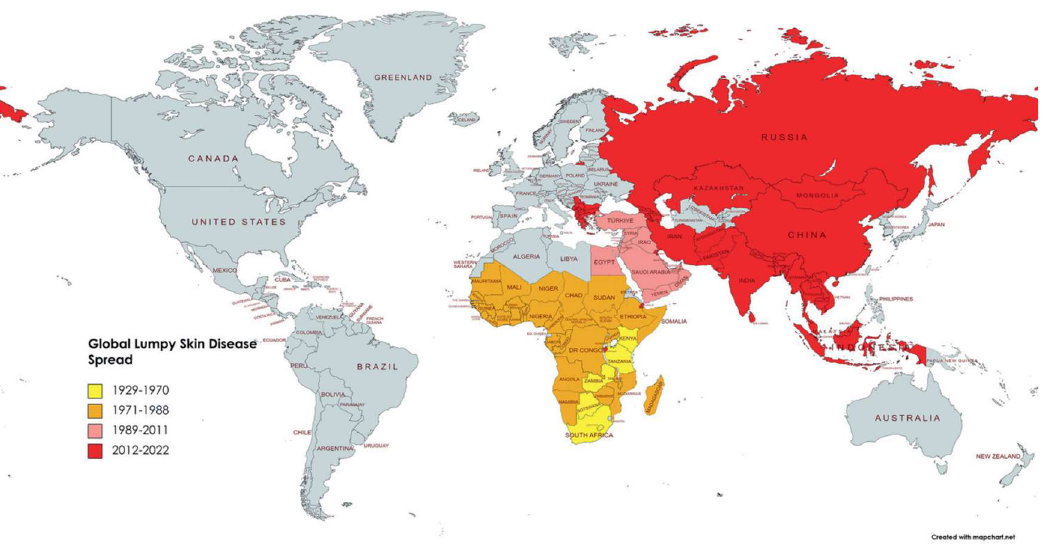
Figure 3. Lumpy skin disease prevalence worldwide and over time from 1929 to 2022. The impacted nations are shown in yellow between 1929 and 1970, orange between 1971 and 1988, pink between 1989 and 2011, and red between 2012 and 2022, with permission from A. Khalafalla, [37].